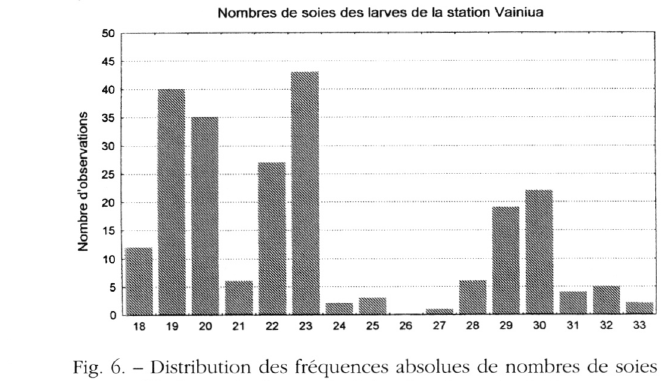
Fig. 6. - Distribution des fréquences absolues de nombres de soies prémandibulaires des larves récoltées dans la station Vainiua (vallée de Pua,